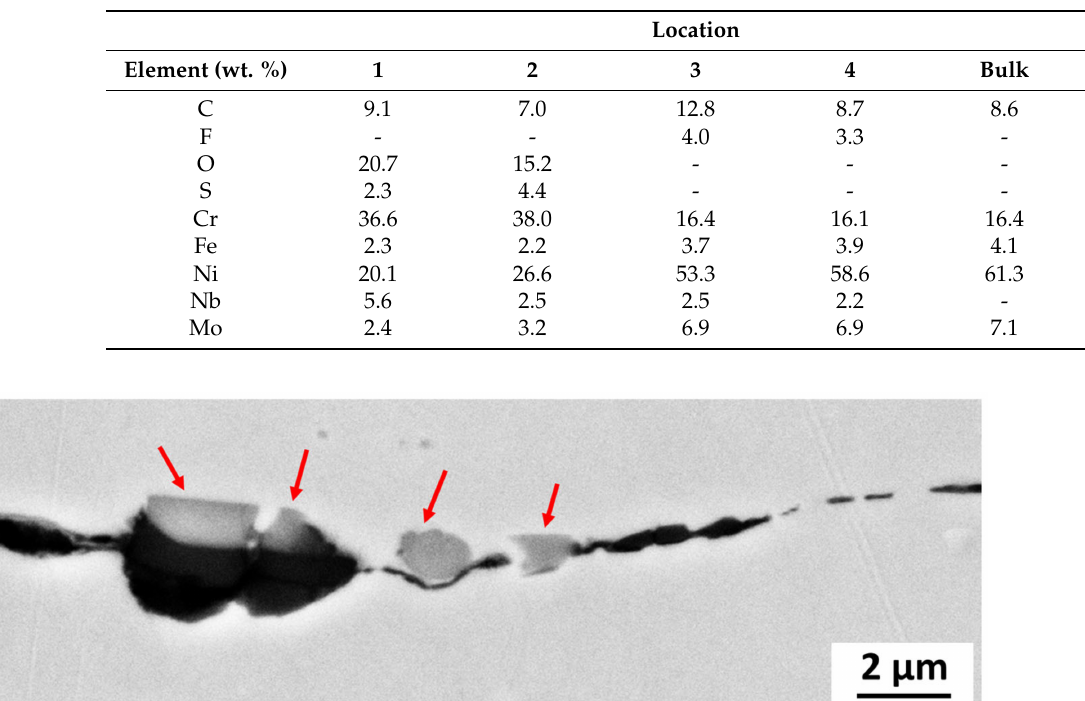
Table 7. EDX elemental analysis of locations shown in Figure 11. For comparison, an analysis of the bulk material after exposure at Reykjanes is included.